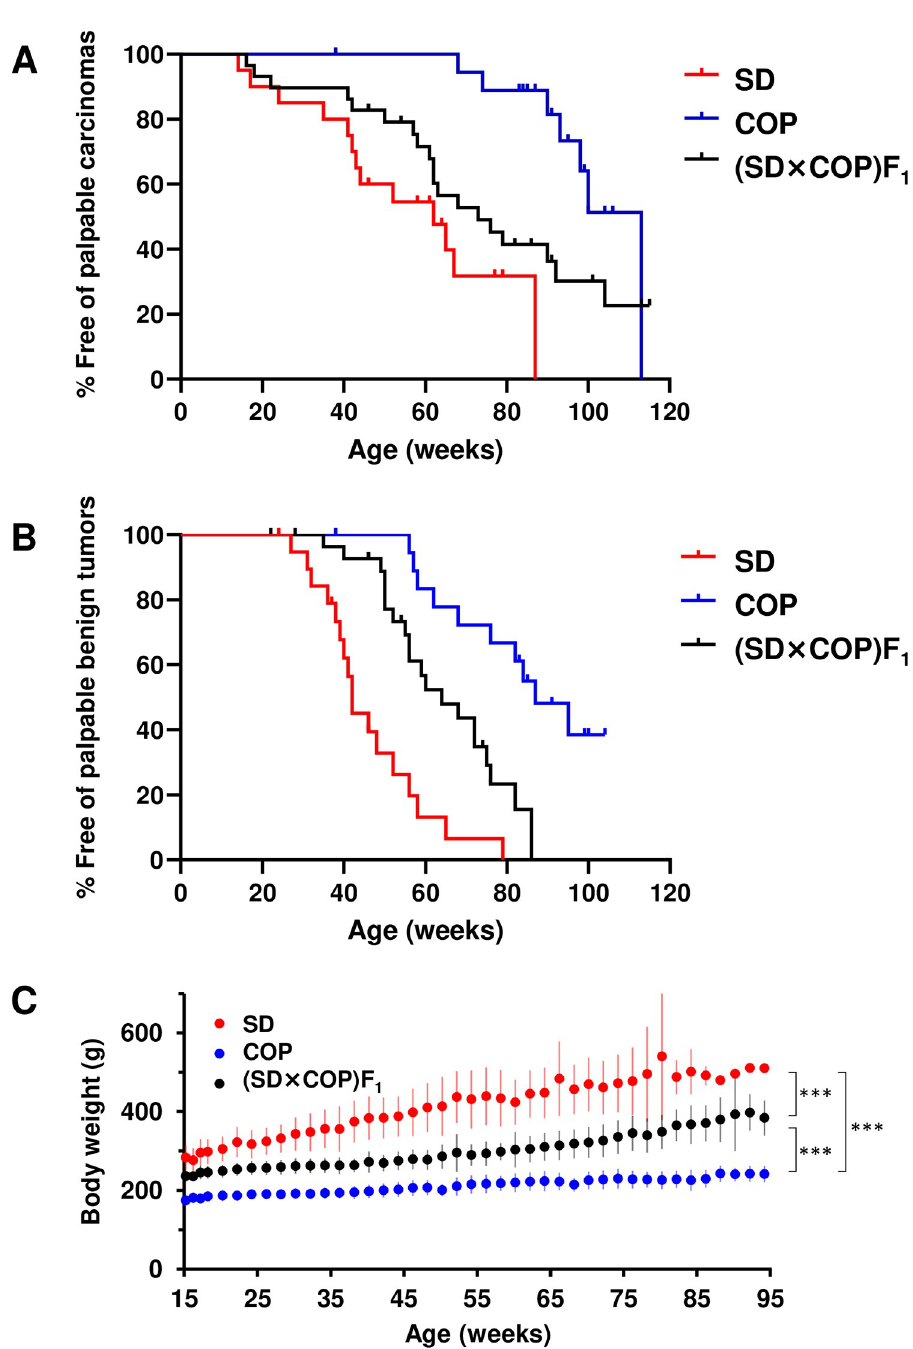
Fig 1. Kaplan-Meier plots of palpable mammary tumor development in Copenhagen (COP), Sprague-Dawley (SD) and hybrid [(SD × COP)F 1 ] rats. A, carcinoma; B, benign tumors (fibroadenoma and adenoma). Data from SD rats were reported previously [17] and reanalyzed. C, Body weight during the experiment (mean and standard deviation). ��� P < 0.001 between strains, two-way analysis of variance.